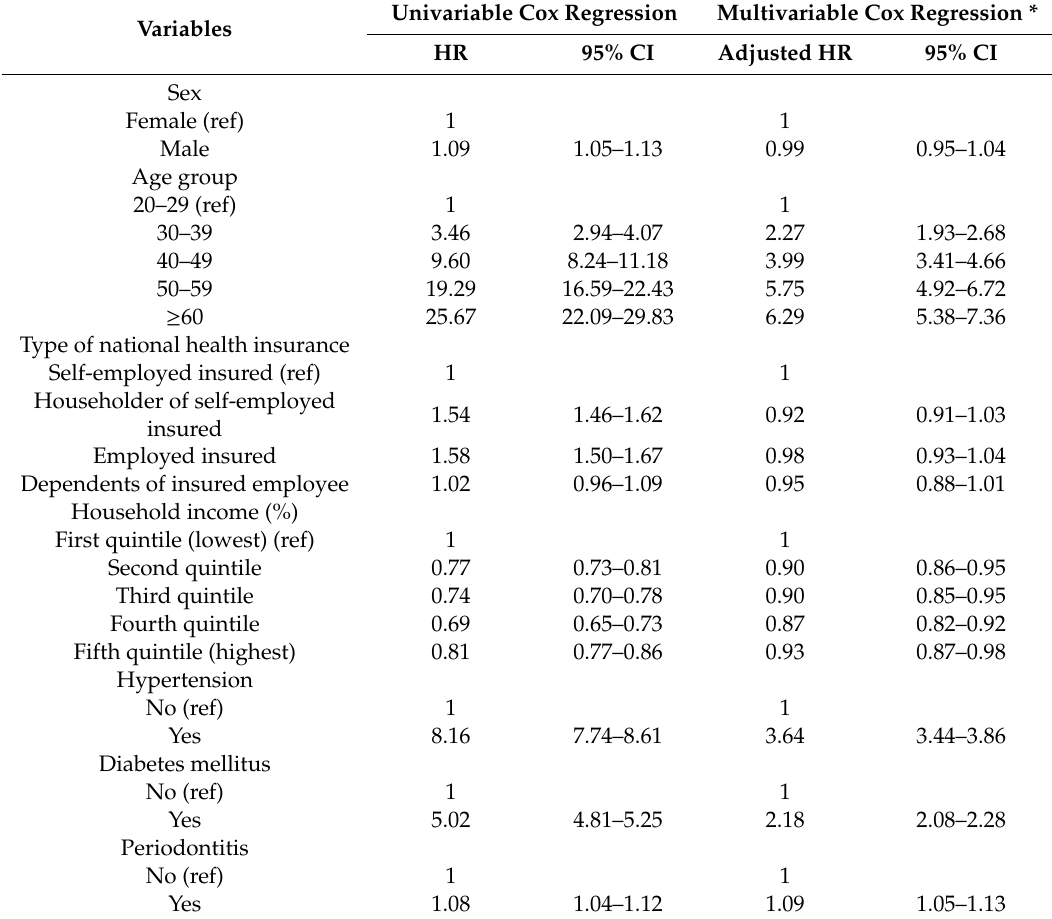
Table 3. Cox proportional hazard regression model for the risk factors of